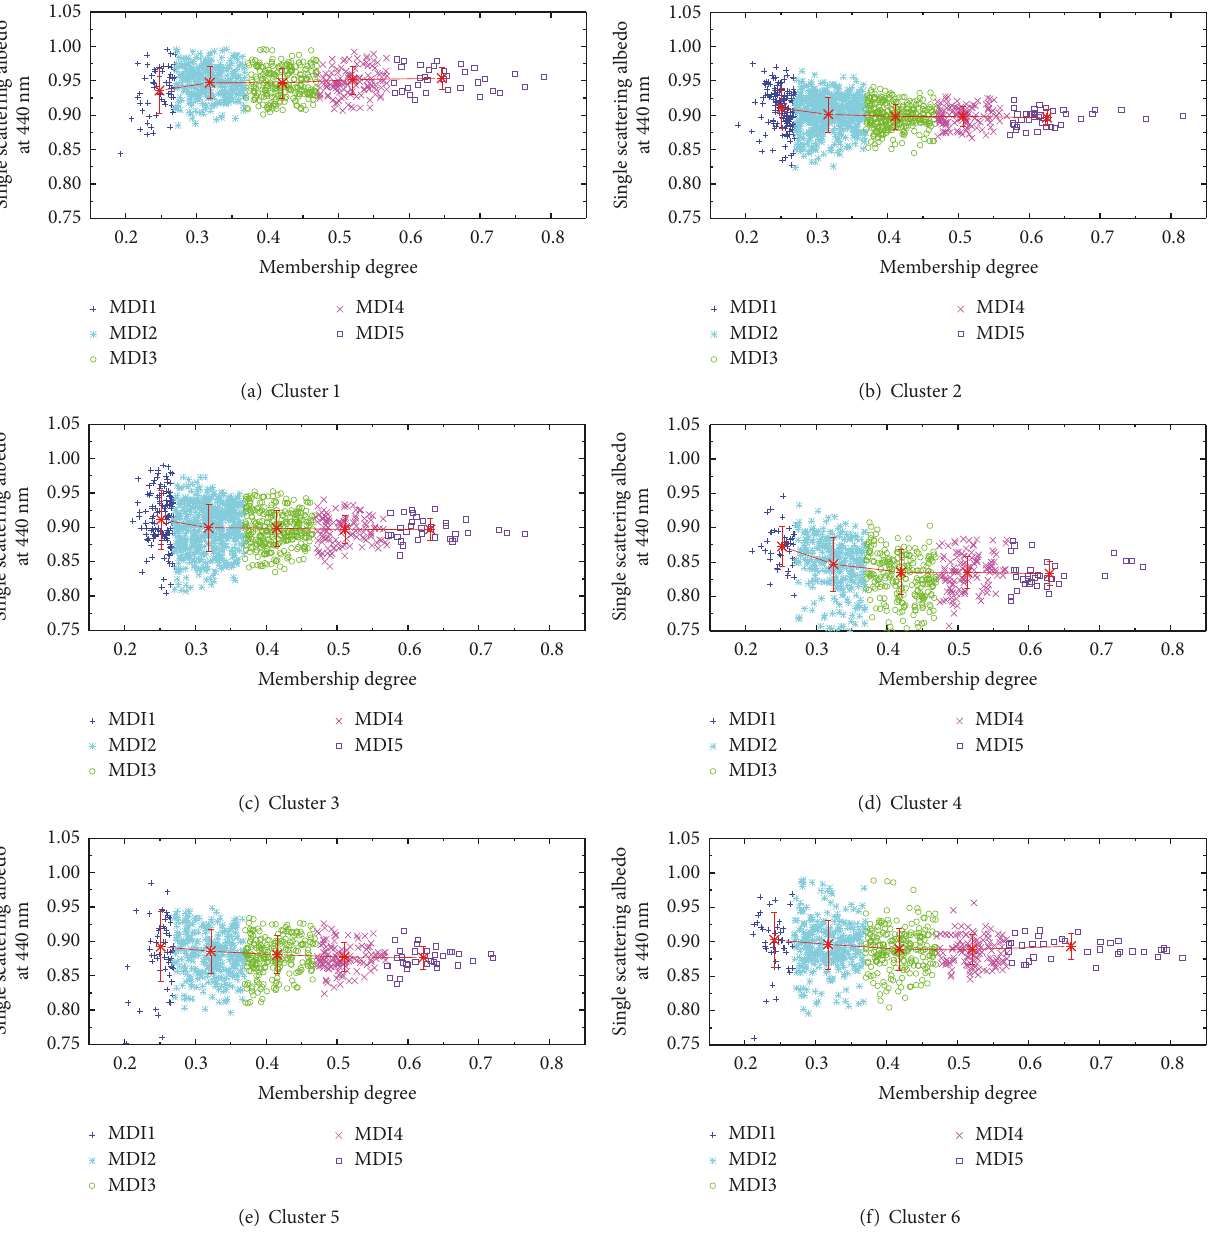
Figure 11: Same as Figure 9 but for SSAs at